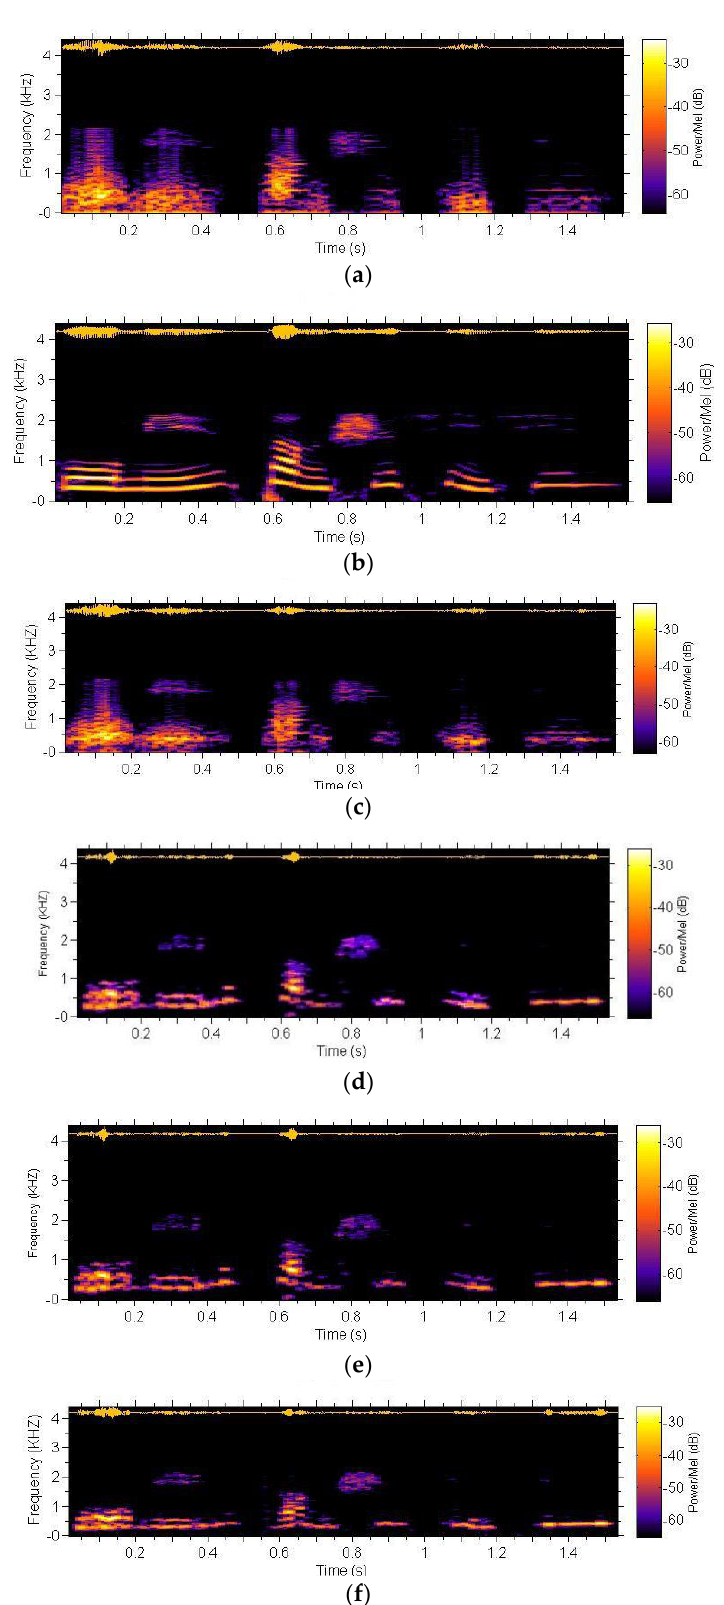
Figure 6. Spectrogram of the sentence “gu min sang shi xin” based on MFCC feature conversion: ( a ) whispered speech; ( b ) normal speech; ( c ) speech converted using LPC; ( d ) speech converted using DNN; ( e ) speech converted using MFCC; ( f ) speech converted using MFCCs.